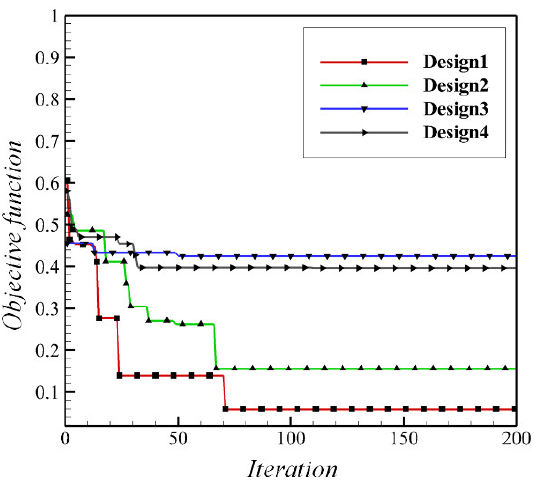
Figure 15. Convergence history of the pressure distribution filtering process. Note that the time cost for each case is around one minute by assuming that the deep learning models are already available. It is believed that deep learning models can be easily trained by high-performance computers and stored in a database. Then, airfoils with various desired features can be found by a desktop computer in